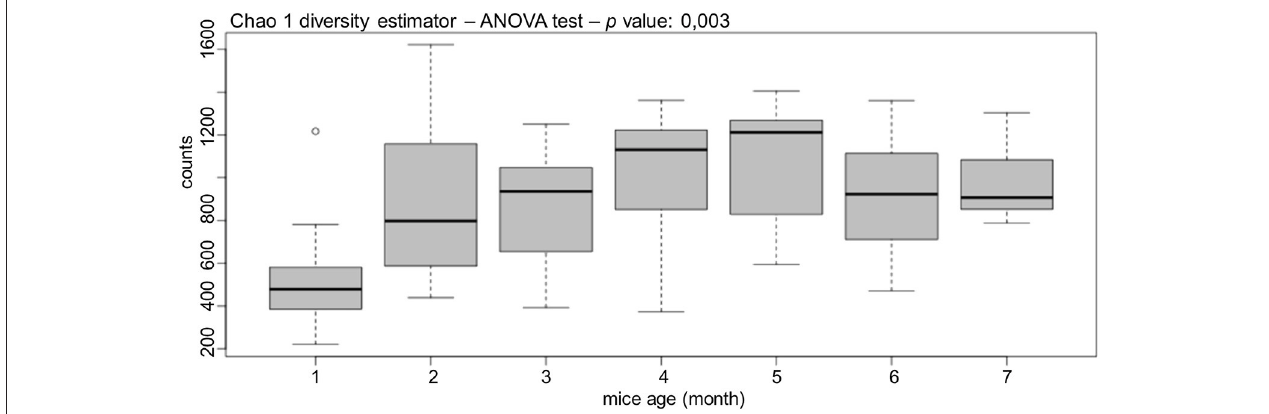
FIGURE 4 | GalT-KO mice bacterial gut population is dynamic. The diversity of gut bacterial population was estimated by months with Chao1 diversity estimator ( n = 77).